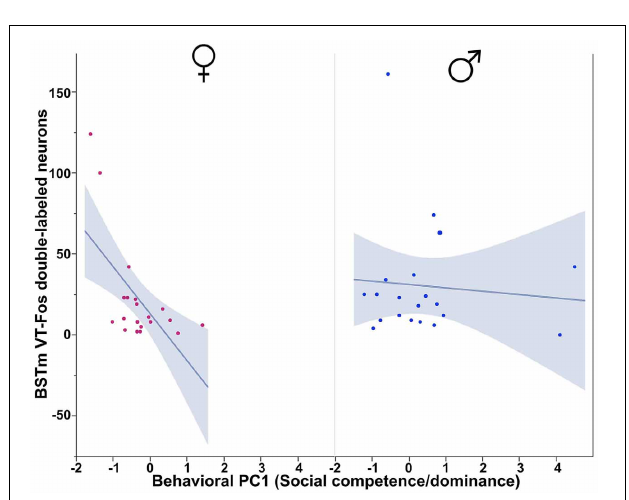
FIGURE 3 | Numbers of VT-Fos double-labeled neurons in the BSTm as a function of an interaction between Sex and Behavioral PC1 (Social competence/dominance). Social competence/dominance tends to correlate negatively with BSTm VT-Fos double-labeled neurons in females but not males. Sex × Behavioral PC1 F ( 1 , 32 ) = 5 . 40, p = 0 . 03. The 95% confidence interval is indicated by shading.